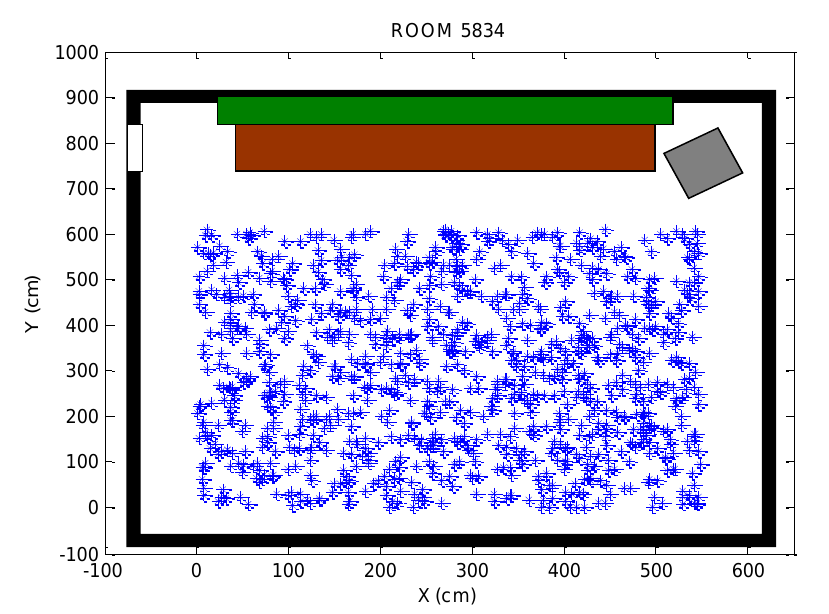
Figure 5. 1,000 particles with uniform distribution in the